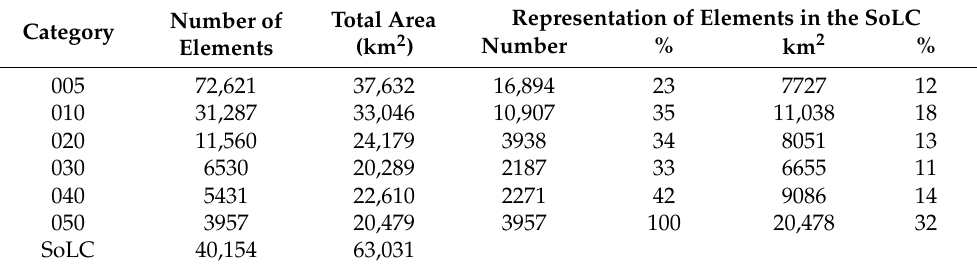
Table 3. Number of catchments and the total area of catchments in each category. The first two columns describe the number of elements in the respective category, and the last two columns indicates the number of elements in